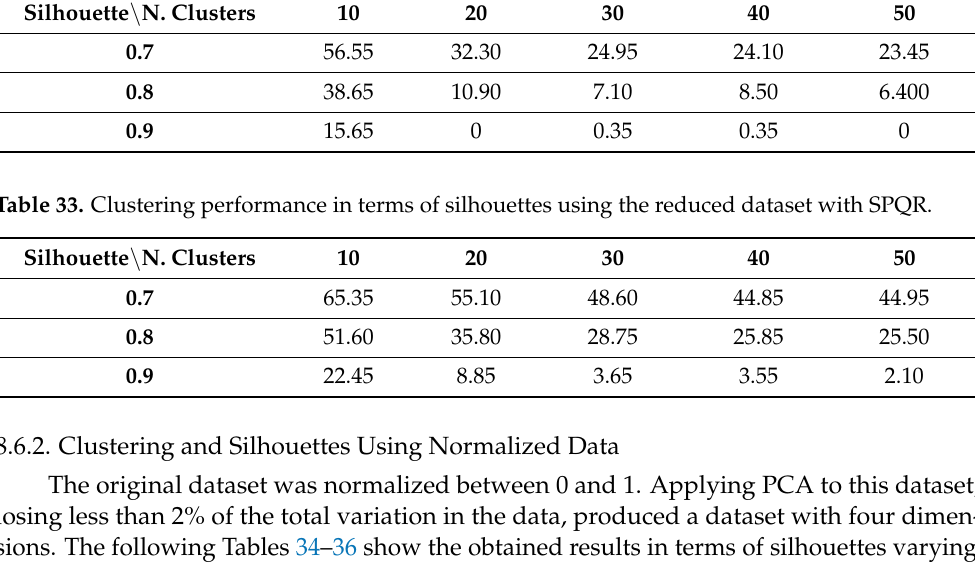
Table 32. Clustering performance in terms of silhouettes using the reduced dataset with PCA. Silhouette \ N. Clusters